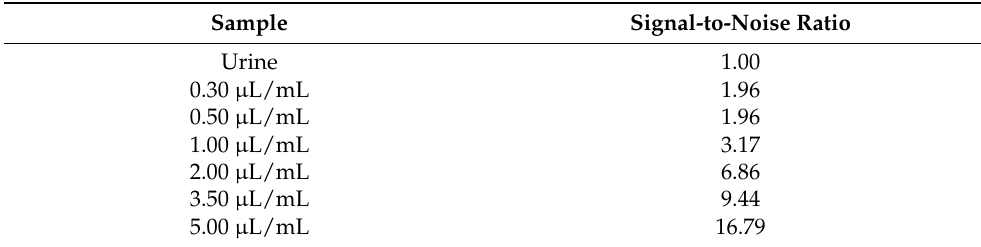
Figure 10. The LoD of ethanol in human urine using the method of gold-coated glass slide with cavity was determined by visual evaluation. Table 3. The LoD of ethanol in human urine for the method of gold-coated glass slide with cavity was determined based on the signal-to-noise ratio.